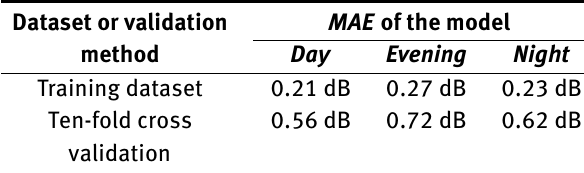
Table 1: Accuracy of the model at location no. 1